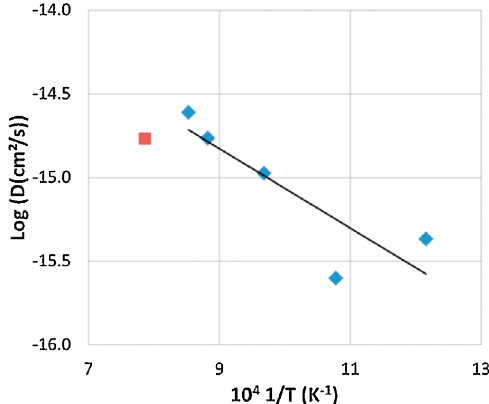
Fig. 9. Arrhenius diagram of the diffusion coef fi cient of 3 He in B 4 C. The 1000 ° C point (in red) was excluded for the linear fi